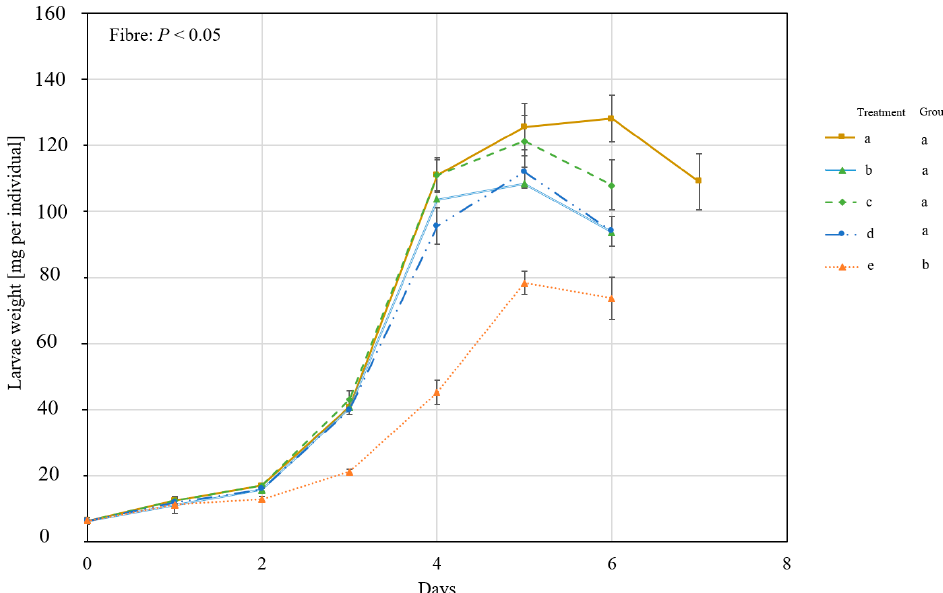
Figure 5. The growth of BSFL on substrates with different straw particle sizes (experiment 2). BSFL were grown on substrates that contain > 3 mm straw (a), 2–3 mm straw (b), 1.25–2 mm straw (c), 1– 1.25 mm straw (d), or ≤ 1 mm straw (e). The single-larva fresh weight was measured over time, and the daily means and the standard errors are shown in the graph. Linear mixed-effect model analysis followed by a Bonferroni post hoc test revealed significant differences between the treatments. Different groups are indicated by the different letters beside the legends.